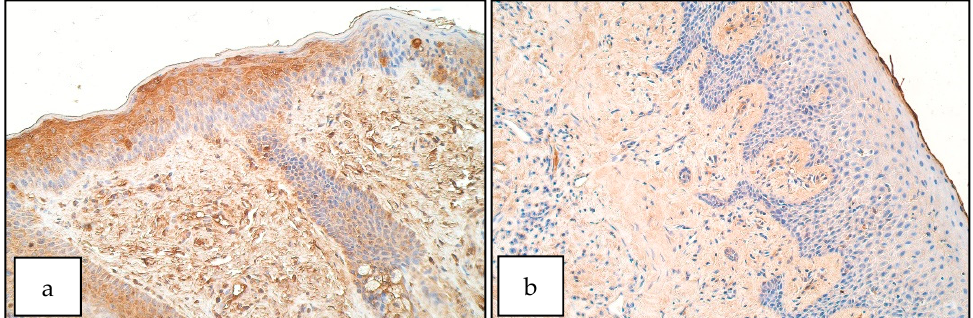
Figure 3. Immunoreactive structures for HOXB3. ( a ) Moderate to numerous HOXB3 positive structures both in patient epithelium and connective tissue, HOXB3 IMH, 200 × . ( b ) A few HOXB3 positive structures in control epithelium, HOXB3 IMH, 200 ×